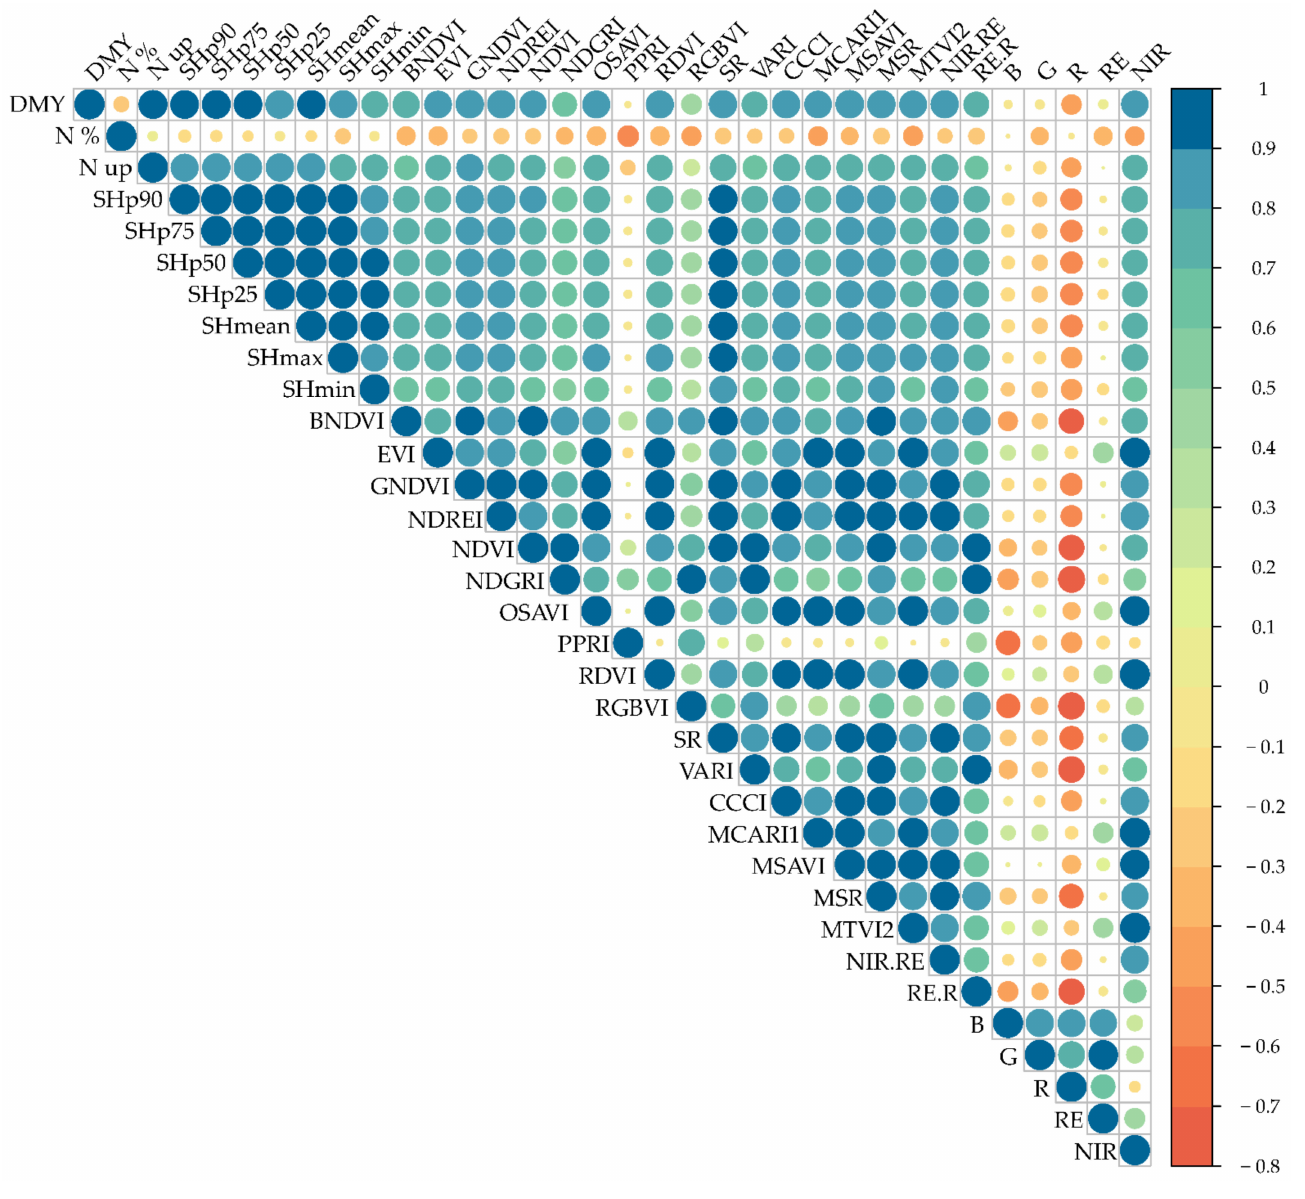
Figure 9. Correlation matrix (Pearson correlation coefficient) of response variables and prediction features (see Tables 2–4 for explanation of